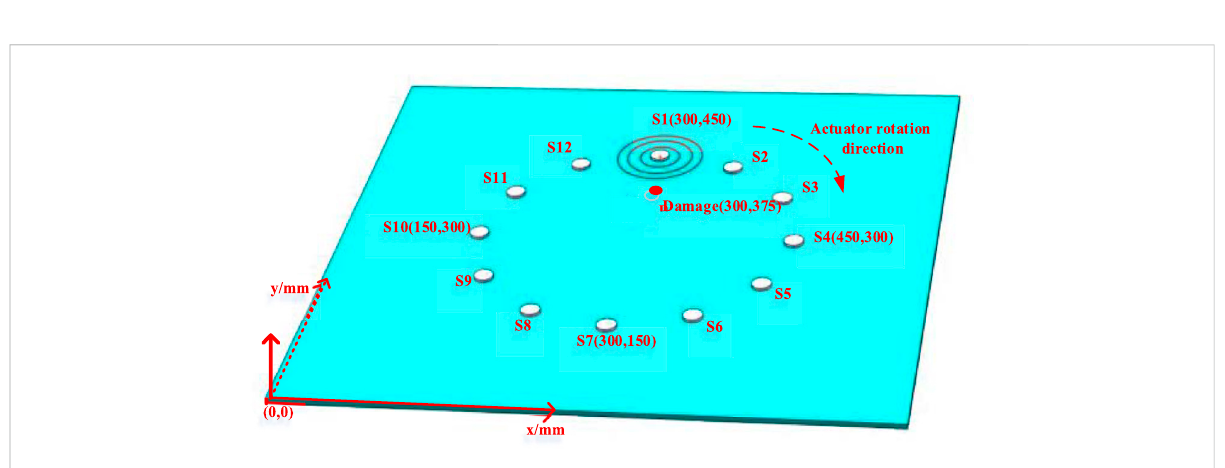
FIGURE 3 Schematic diagram of sensor and single damage location.